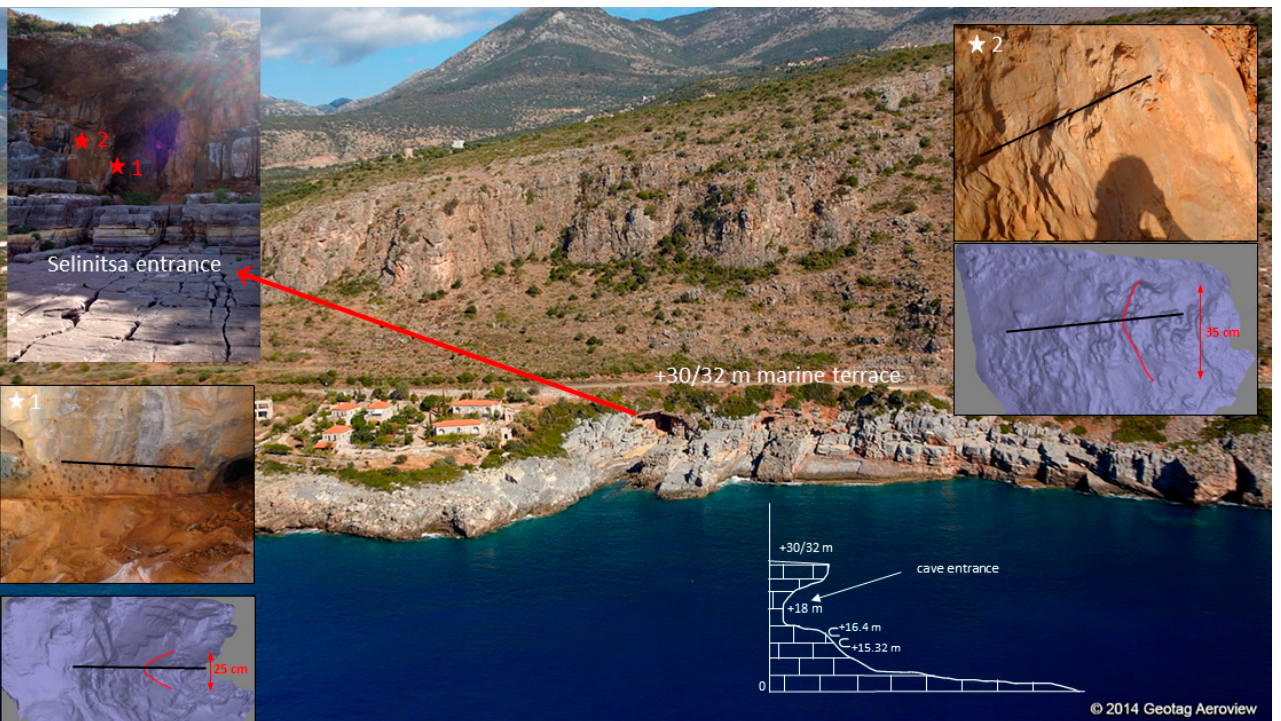
Figure 3. View from the west of the entrance to Selinitsa Cave and its wider coastal area. The embedded pictures (1 and 2) show the lower and upper notch (*1 and *2, respectively), as well as their 3D models, respectively. The black lines in the images depict former mean sea levels. The schematic section on the bottom right addresses the vertical arrangement of the area’s geomorphological features.